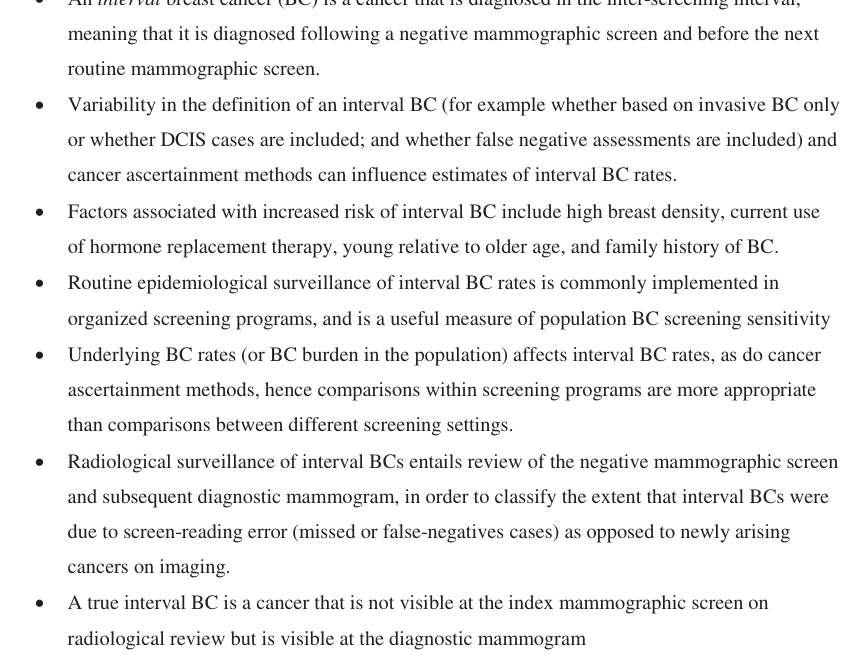
Fig. 1 Summary of background de fi nitions and